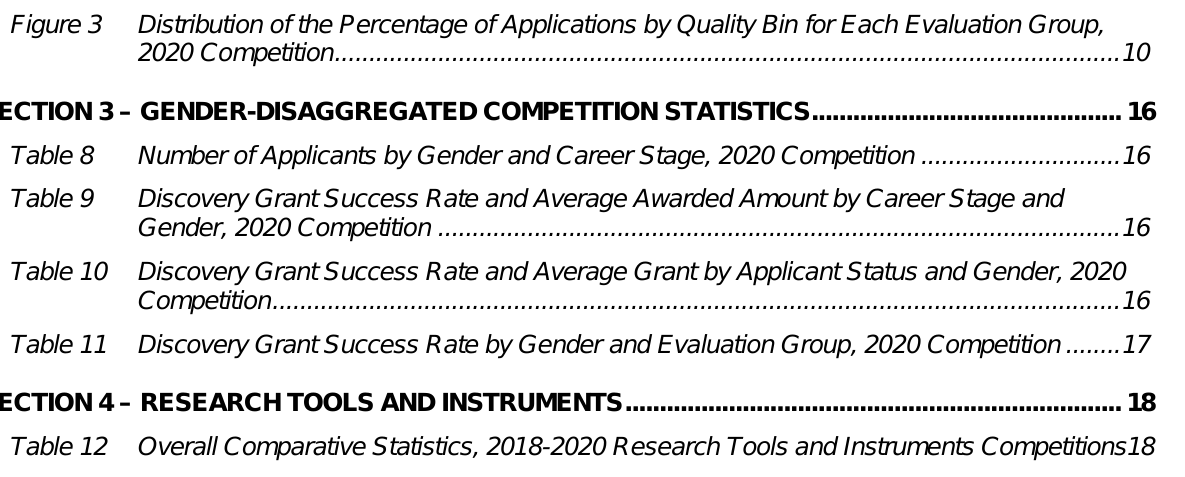
Overall Comparative Statistics, 2018-2020 Research Tools and Instruments Competitions18 Research Tools and Instruments 2020 Competition Results by Selection Committee ........